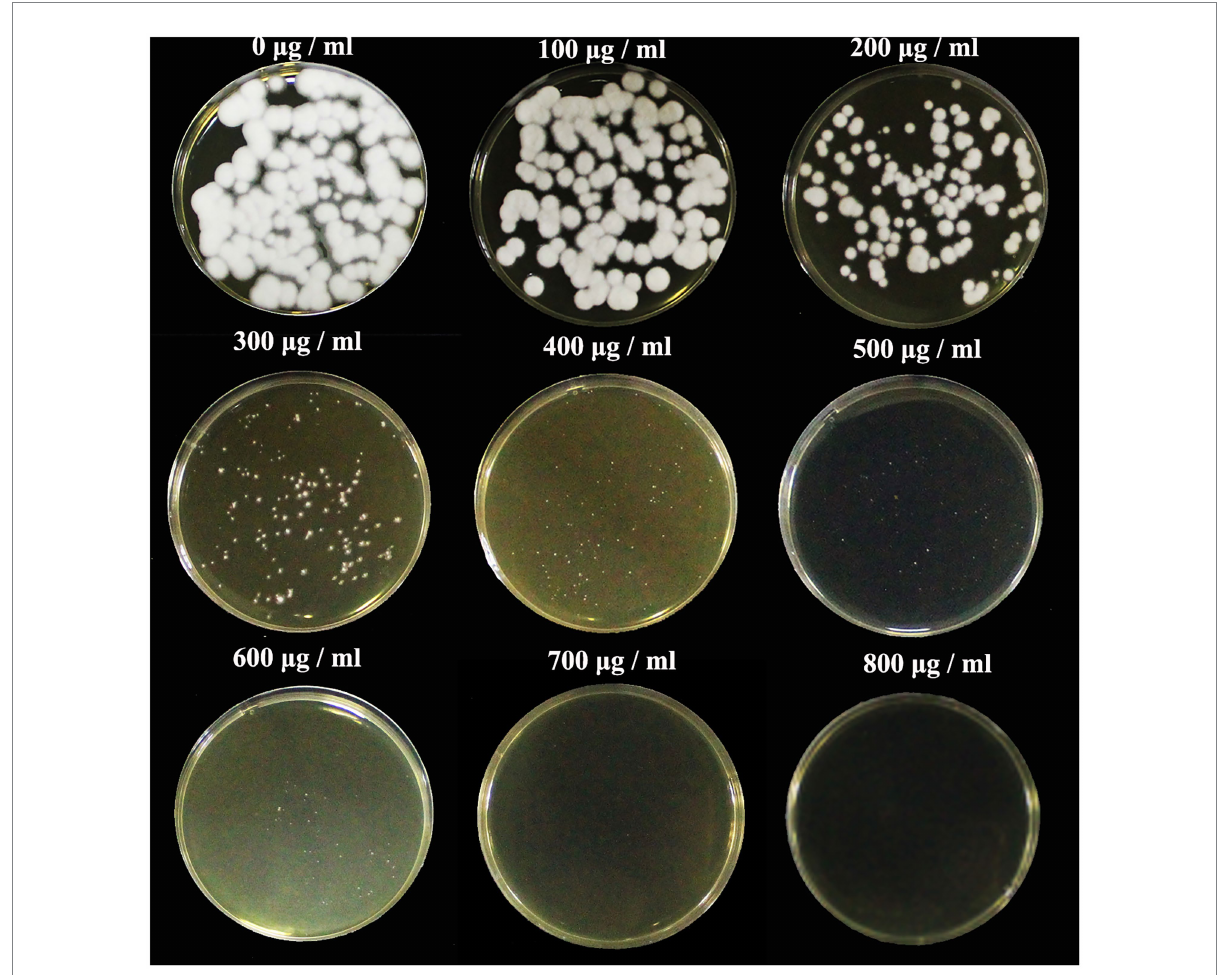
FIGURE 1 Sensitivity of Cordyceps javanica BE01 protoplasts to G418. SDAY medium was supplemented with different concentrations of G418 (0– 800 μ g ml − 1 ), and samples were incubated for 7 days at 25 °